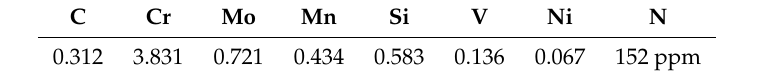
Table 1. Chemical composition of the steel matrix 32CrMoV13 (data from Mecachrome).